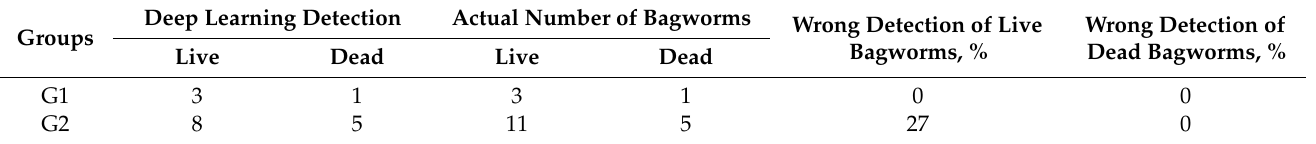
Table 5. Algorithm performance on the determination of living and dead bagworms according to bagworm group. Deep Learning Detection Groups